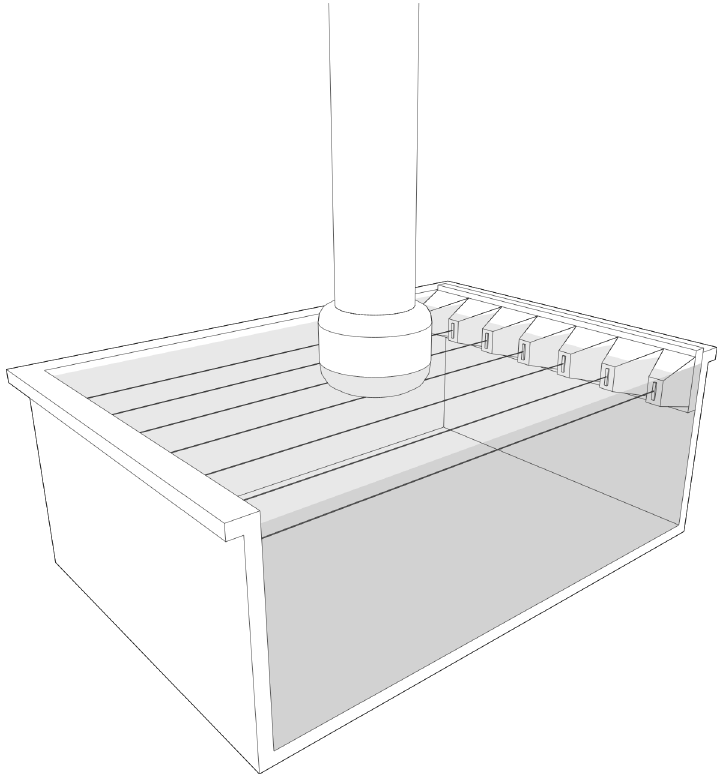
Fig 2. Surface heating test object. Persplex cube containing hydrogel; sides covered with damping material (Aptflex, Precision Acoustics, UK). Surface heating of the different probes was measured via a sensor, which was attached to the probe ’ s surface within the Doppler sound